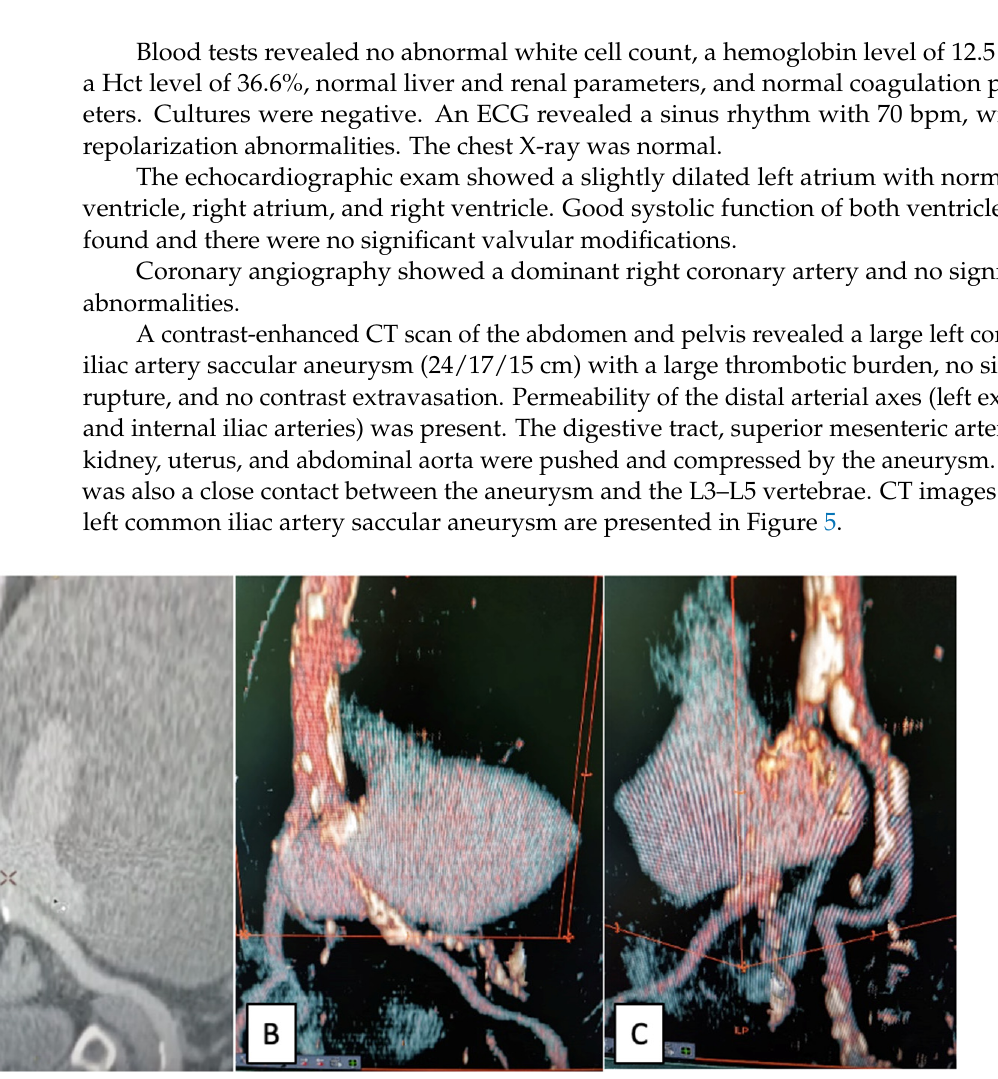
Figure 5. CT images of the left common iliac artery saccular aneurysm: ( A )—coronal view; ( B , C )—3D reconstruction.